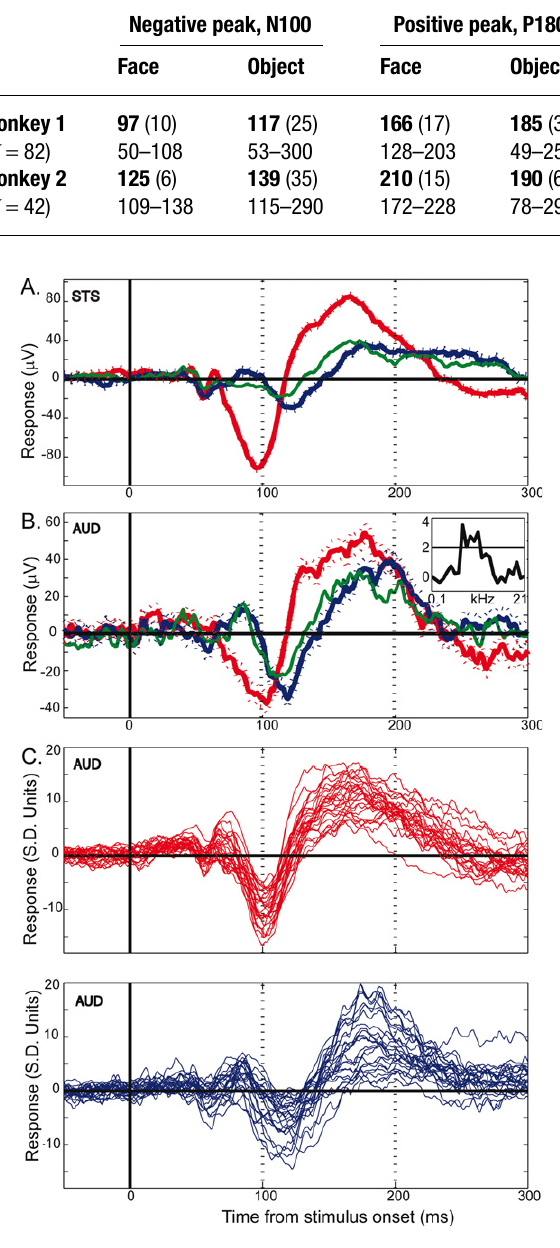
Figure 4. Example LFP responses to face and object categories. (A) Mean ( ± SEM) responses to face (red), object (blue) and Greeble (green) categories for one electrode site in upper-bank STS from Monkey 1. Responses are shown in μ V, aligned to stimulus onset (in ms); each response refl ects the mean of 120 trials, with thin lines indicating the SEM. (B) Responses from one electrode site in the lateral belt of auditory cortex, recorded simultaneously with the STS responses shown in A, using the same conventions. The inset displays the fre- quency tuning for this electrode site for 25 tones played at 72 dB. The black line in the inset marks 2 standard deviations above baseline activity. See Figure 6 for another simultaneously recorded pair of STS and auditory cortex face responses. (C) Mean responses to faces (top, red) and objects (bottom, blue) are shown for 26 auditory cortex electrode sites. The 26 traces are comprised of two randomly selected sites from each of 13 randomly selected recording sessions. The x -axis is identical to that of A and B; the y -axis shows responses in z -score units from the baseline distribution. Typically, both face and object responses are statistically signifi cant during the two major LFP components, and the object responses are more variable and lag behind responses to faces.